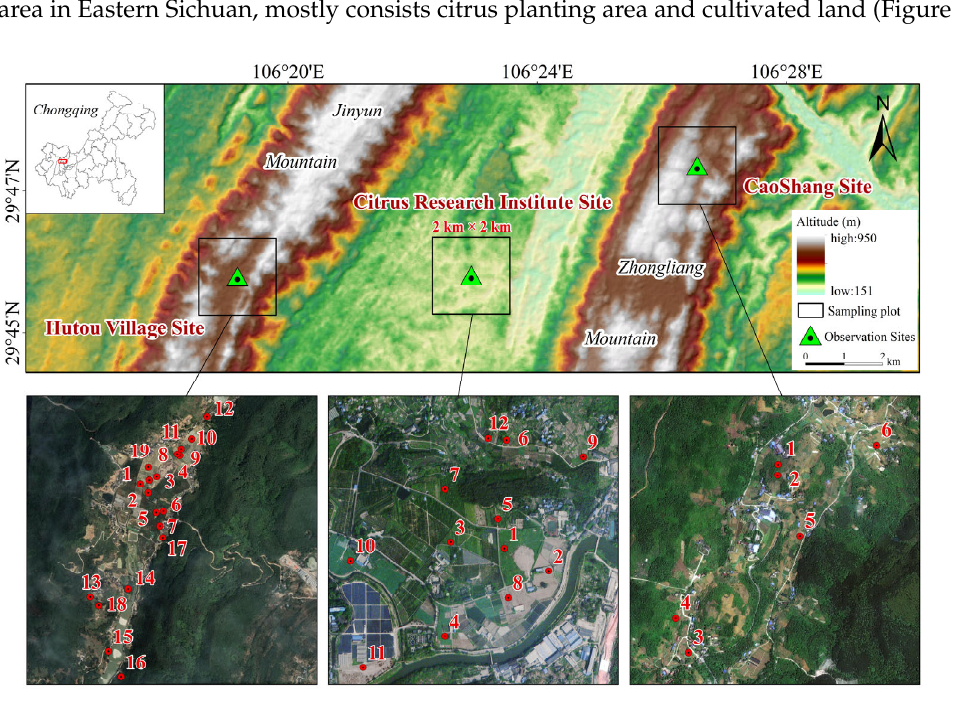
Figure 1. Study area and ESU locations. Elevation data were derived from the advanced spaceborne thermal emission and reflection radiometer global digital elevation model (ASTER GDEM) data at 30 m spatial resolution; red points represent the ground ESUs. Base maps came from Google Satellite and Tianditu